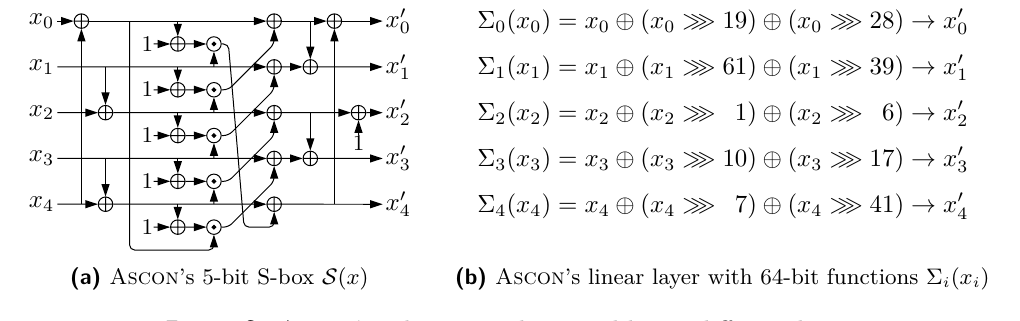
Figure 2: Ascon ’s substitution layer and linear diffusion